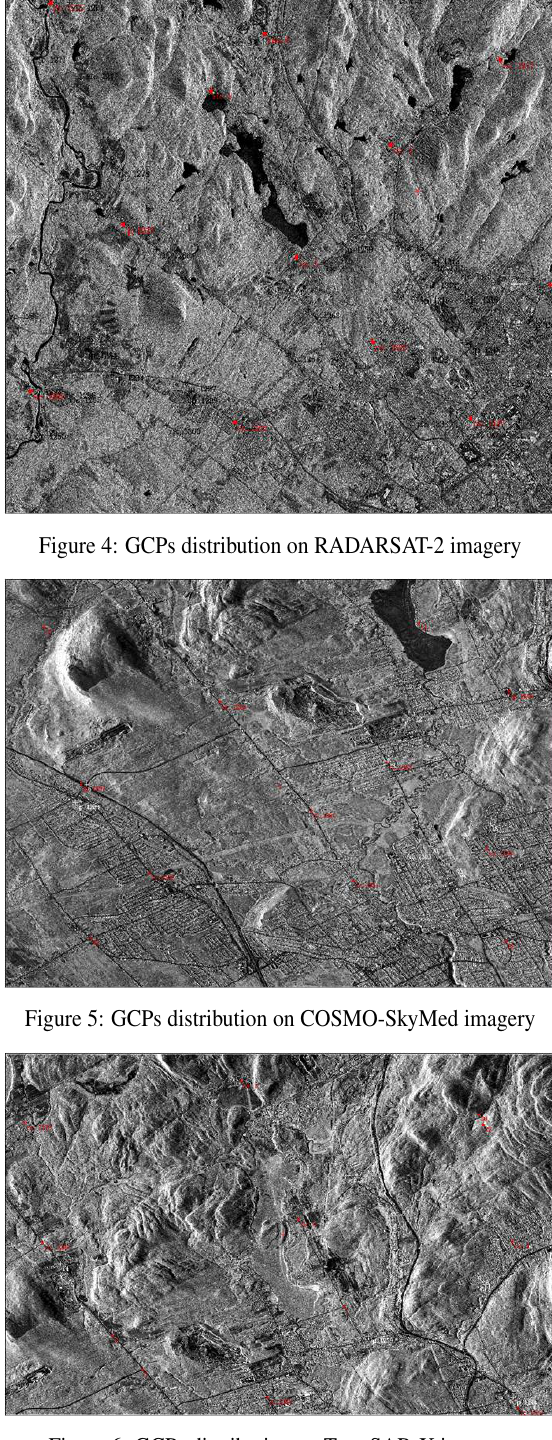
Figure 6: GCPs distribution on TerraSAR-X